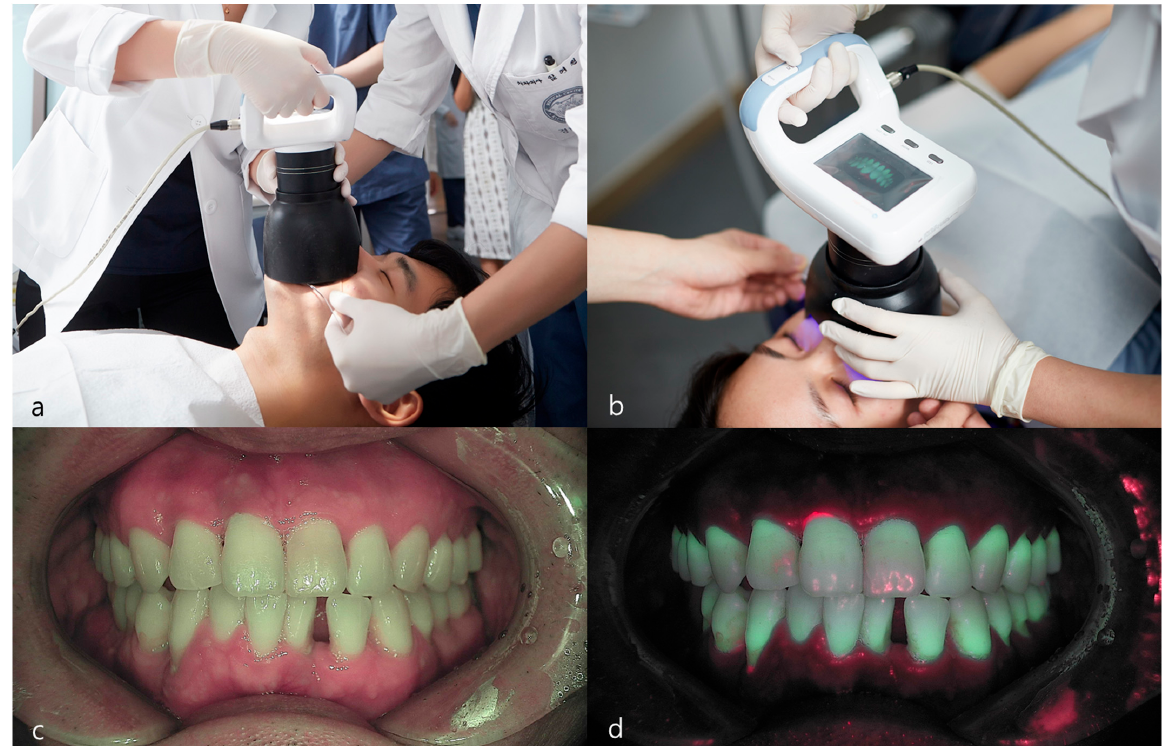
Figure 2. White-light and fluorescent images of the anterior teeth were captured using a Qraycam Pro ® (AIOBIO, Seoul, Korea). ( a , b ) QLF system was equipped with a metal tube that blocked external light to prevent contamination of the fluorescent image. The participants maintained an edge-to-edge occlusion while capturing the images. ( c ) White-light image; ( d ) fluorescent image.